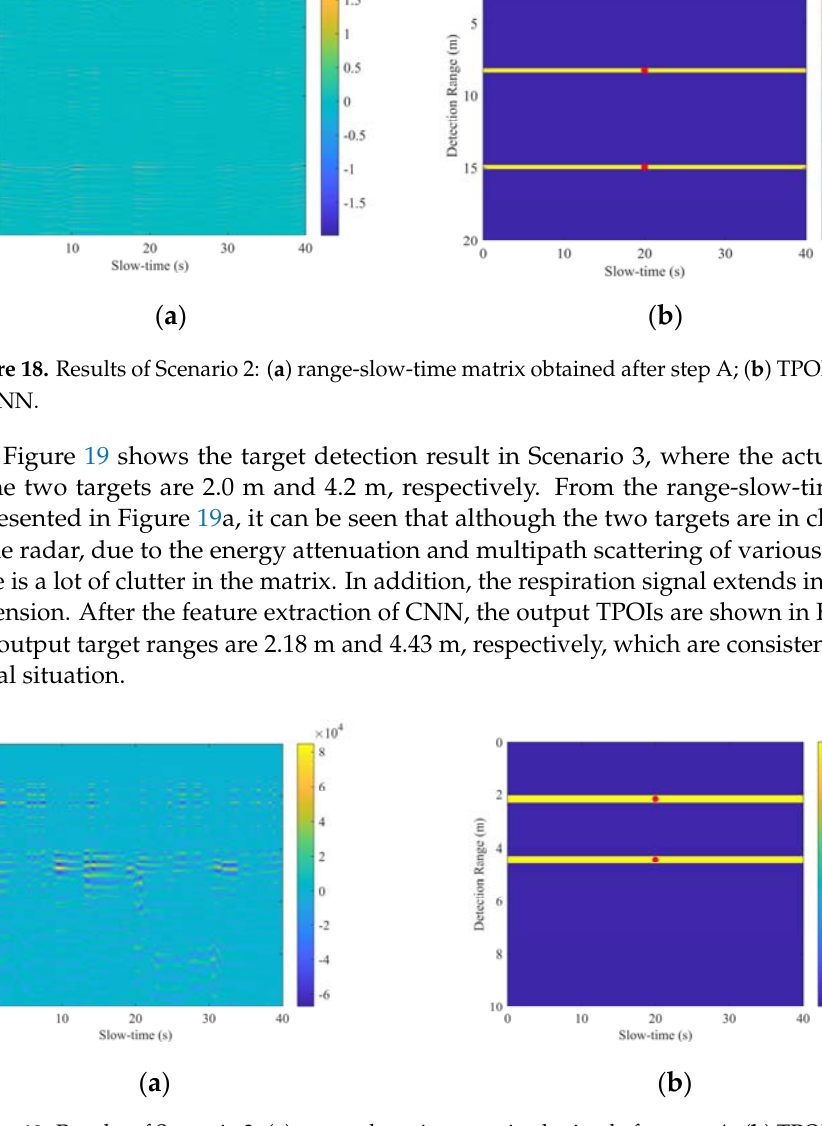
Figure 19. Results of Scenario 3: ( a ) range-slow-time matrix obtained after step A; ( b ) TPOIs extracted by CNN.